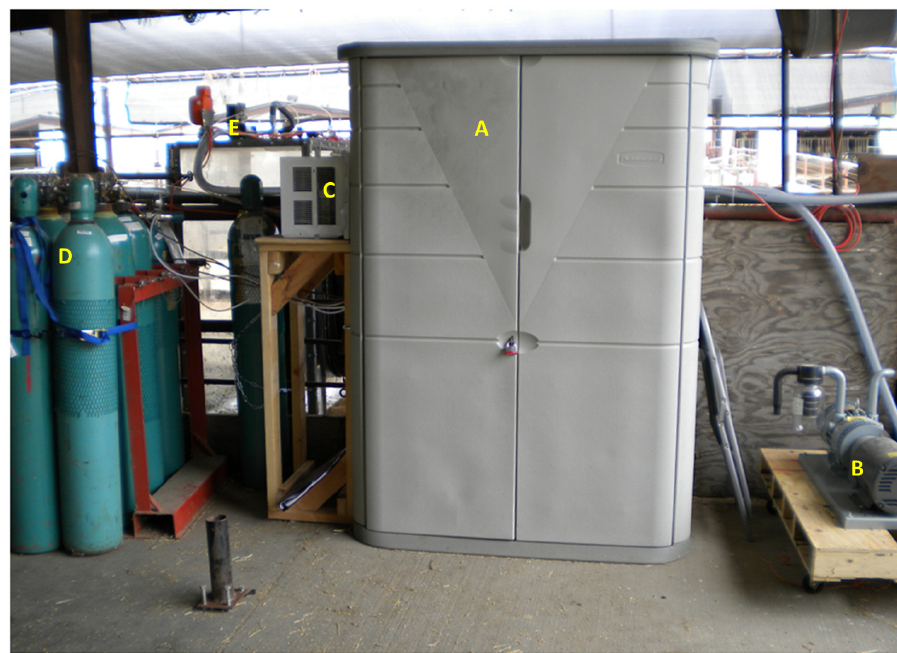
Figure 6. A photo of the instrumentation cabinet closed. (A) is the closed instrumentation cabinet housing the gas analyzers. (B) is one of 2 rotary vane vacuum pumps powered by 5 HP electric motors. (C) is an A/C unit used to cool the inside of the instrumentation cabinet. (D) are cylinders used for calibration of some of the analyzers, and as carrier and fuel gases for the TEI-55C analyzer. (E) is one of the head hoods in operation.